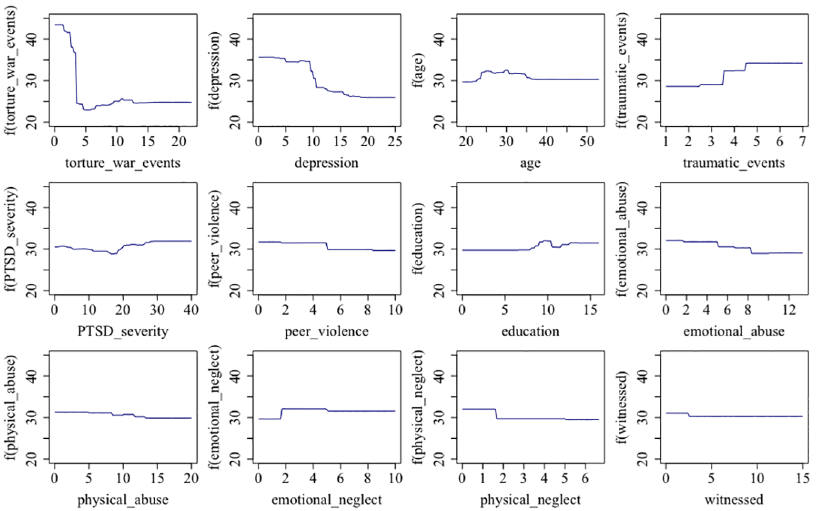
Fig 1. Partial dependency plots for the first 12 variables. For each predictor variable(displayedon the abscissas) the numberof adjusted pumps (displayed on the ordinate)is shown as a function of the former.